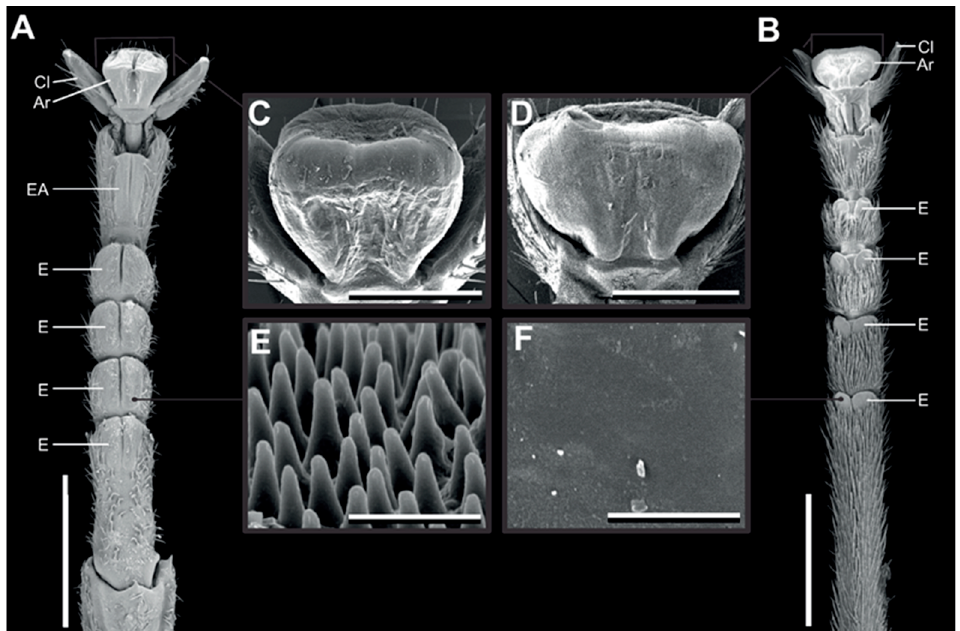
Figure 1. Tarsal morphology. Scanning electron micrographs of the feet of Sungaya inexpectata ( A , C , E ) and Medauroidea extradentata ( B , D , F ). ( A , B ) Ventral overviews. ( C , D ) Arolia. ( E , F ) microstructure of the euplantulae. Ar, arolium; EA, accessory euplantula (5th euplantula); E, euplantula; Cl, claw. Scale bars: 1 mm ( A , B ), 300 µm ( C , D ), 3 µm ( E , F ). Figure from Büscher and Gorb 2019 [26] reproduced with permission.